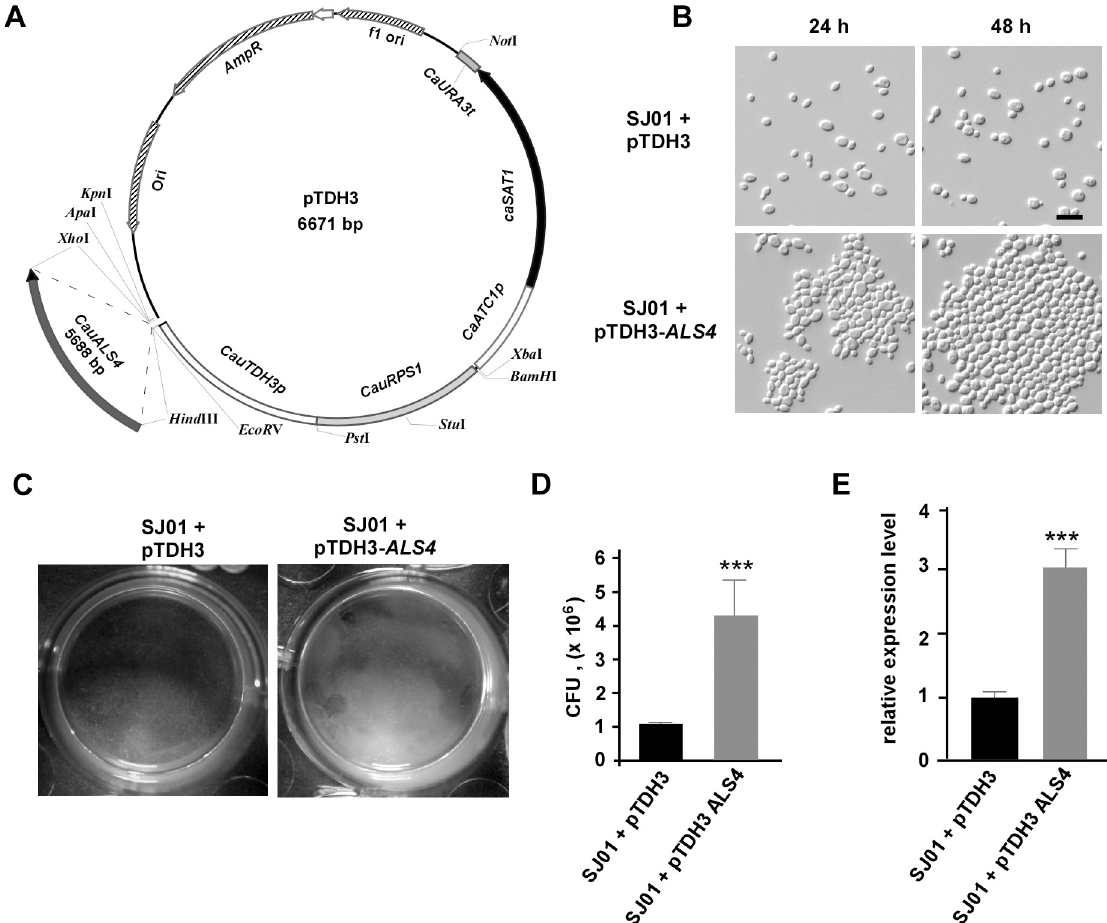
Fig 9. Ectopic expression of ALS4 in strain SJ01 promotes cell aggregation and biofilm formation. (A) Diagram of plasmid pTDH3-ALS4. RPS1 and TDH3-associated fragments were amplified from genomic DNA of C . auris . c aSAT1 , CaACT1 promoter ( C . albicans ACT1p ), and CaURA3 terminator ( C . albicans URA3t ) were amplified from plasmid pNIM1. (B) Cellular morphologies of the control and ALS4-ecotopic strains. Cells of strain SJ01 (bearing a shortened single copy of ALS4 ) were transformed with linearized plasmids pTDH3 (vector-alone control) or pTDH3-ALS4. Fungal cells were cultured in liquid YPD medium at 30˚C for 24 or 48 hours. Scale bar, 10 μ m. (C) Biofilm formation of the control and ALS4 -ecotopic strains on the bottoms of 24-well plate polystyrene plates. (D) Quantitative analysis of CFUs obtained from biofilms formed on the bottoms of the polystyrene plate wells in D. ��� p < 0.001, two-tailed Student’s t test. (E) Relative expression levels of ALS4 in the control and ALS4-ecotopic strains determined by Q-RT-PCR assays. ��� p < 0.001, two-tailed Student’s t